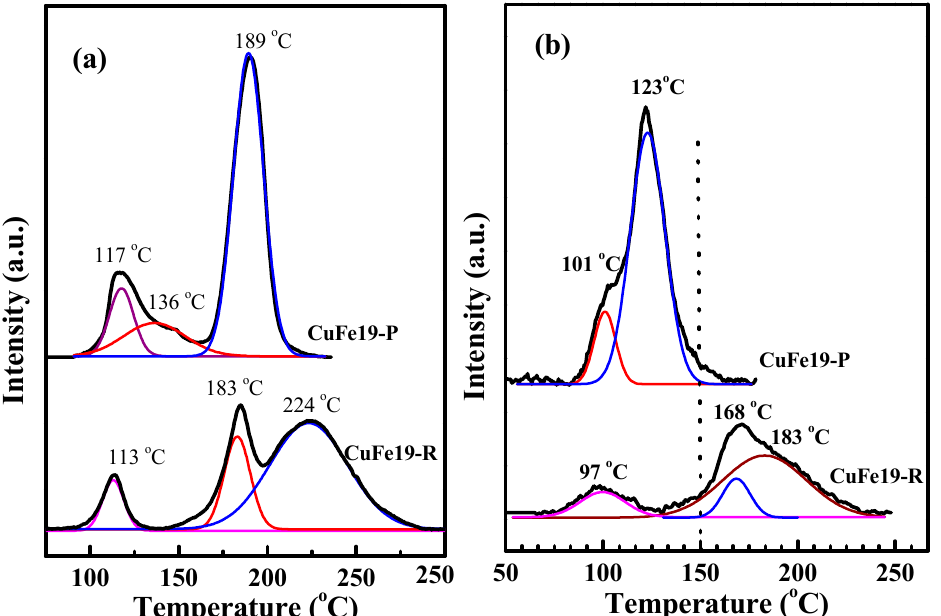
Figure 8. s ‐ TPR profiles of CuFe19 ‐ P and CuFe19 ‐ R. ( a ): the first TPR run; ( b ): the second TPR run. Figure 8. s-TPR profiles of CuFe19-P and CuFe19-R. ( a ): the first TPR run; ( b ): the second TPR run.